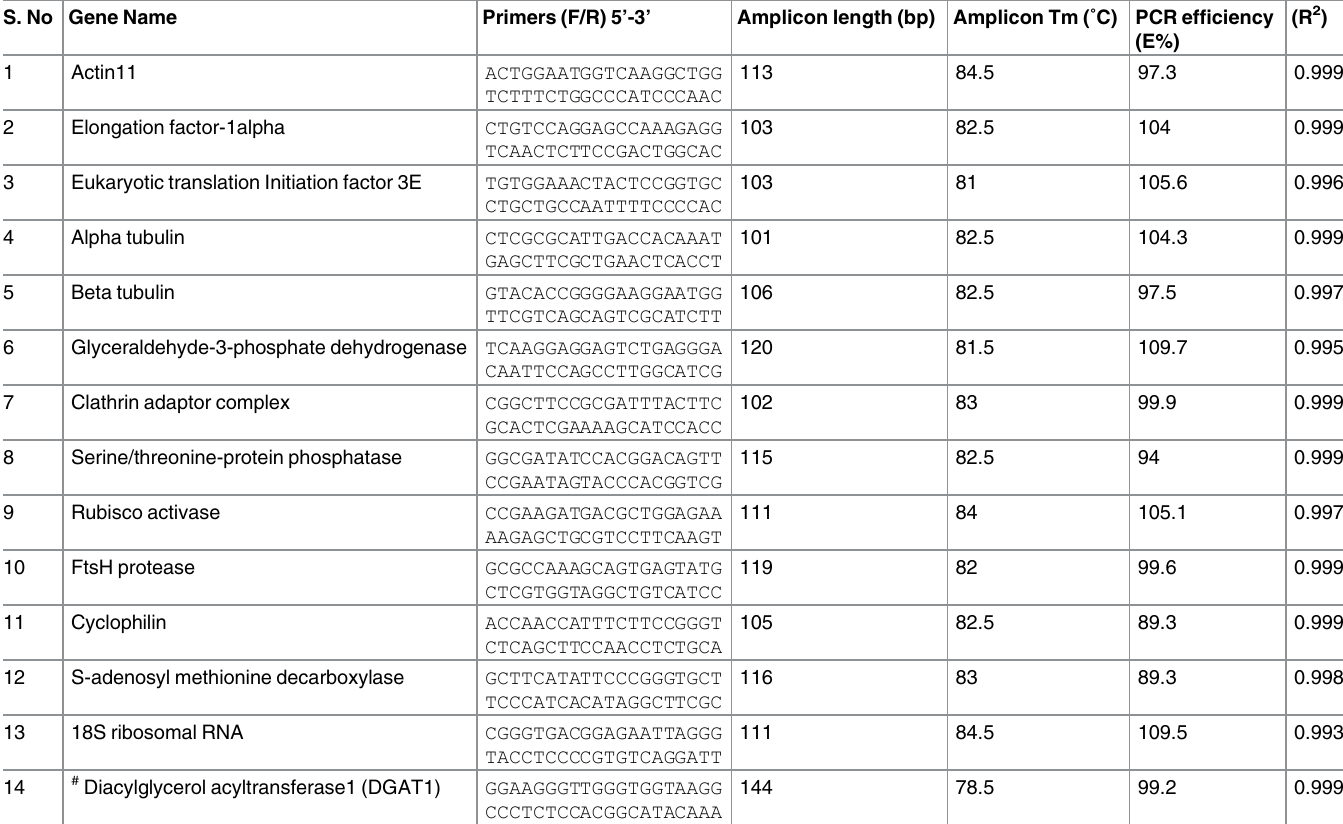
Table 2. Comprehensive details of genes and primer sets used for qRT-PCR.